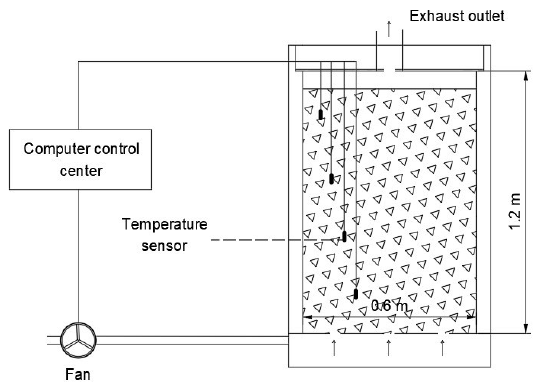
Figure 1. Schematic of the aerobic composting automatic control device.